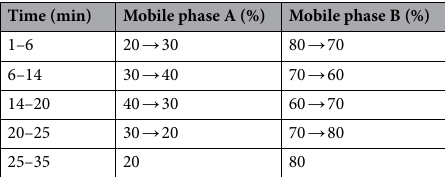
trate to properly dilute, and add SrCl 2 solution to make the concentration of Sr 2+ 1 g L −1 . The content of Ca was determined by atomic absorption spectrometer (Thermo ICE™ 3300 AAS, USA).